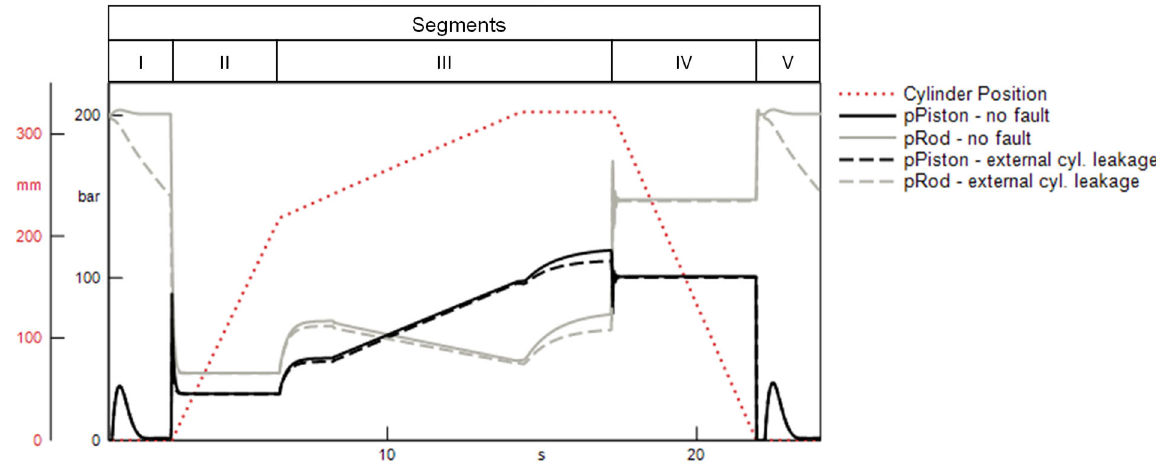
Figure 12. Simulated effect of an external cylinder leakage on the cylinder pressures.